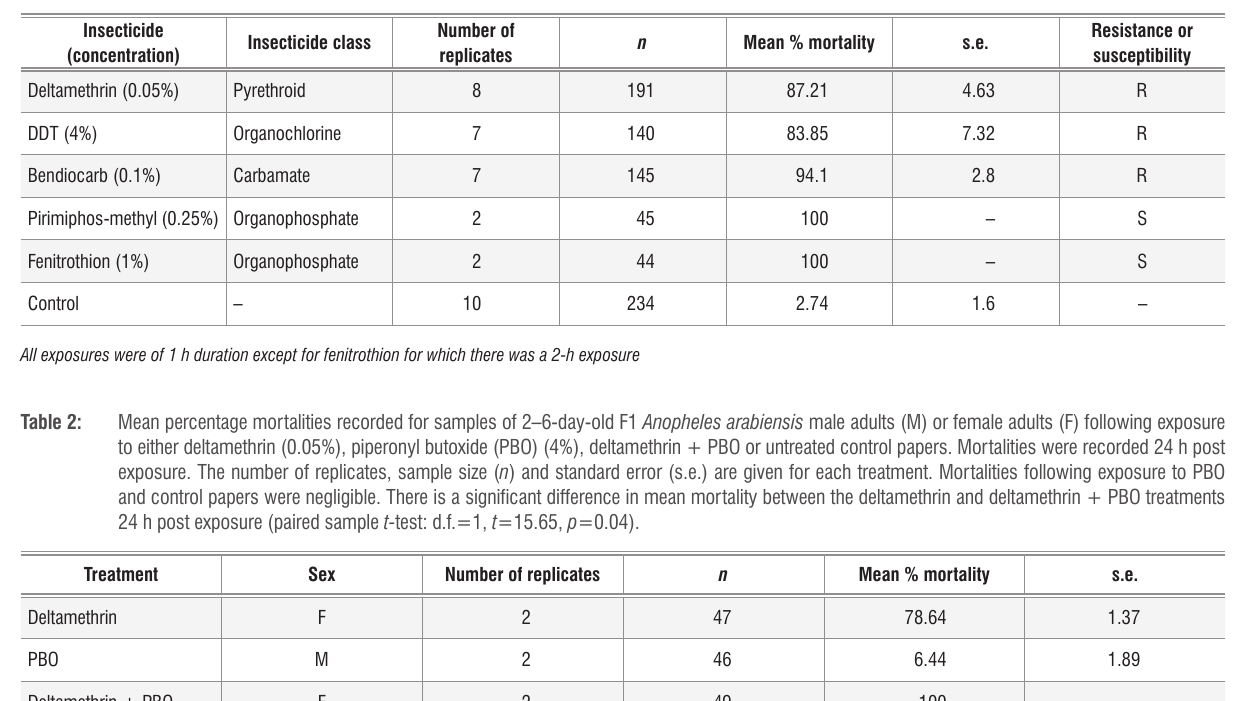
Mean percentage mortalities recorded for samples of 2–5-day-old F1 Anopheles arabiensis female adults following exposure to listed insecticides by class. Mortalities were recorded 24 h post exposure. The number of replicates, sample size ( n ) and standard error (s.e.) are given for each insecticide treatment. Samples by treatment are categorised as resistant (R) or susceptible (S) according to standard criteria. 13 The control was exposure of 2–4-day-old F1 Anopheles arabiensis male adults to untreated papers.